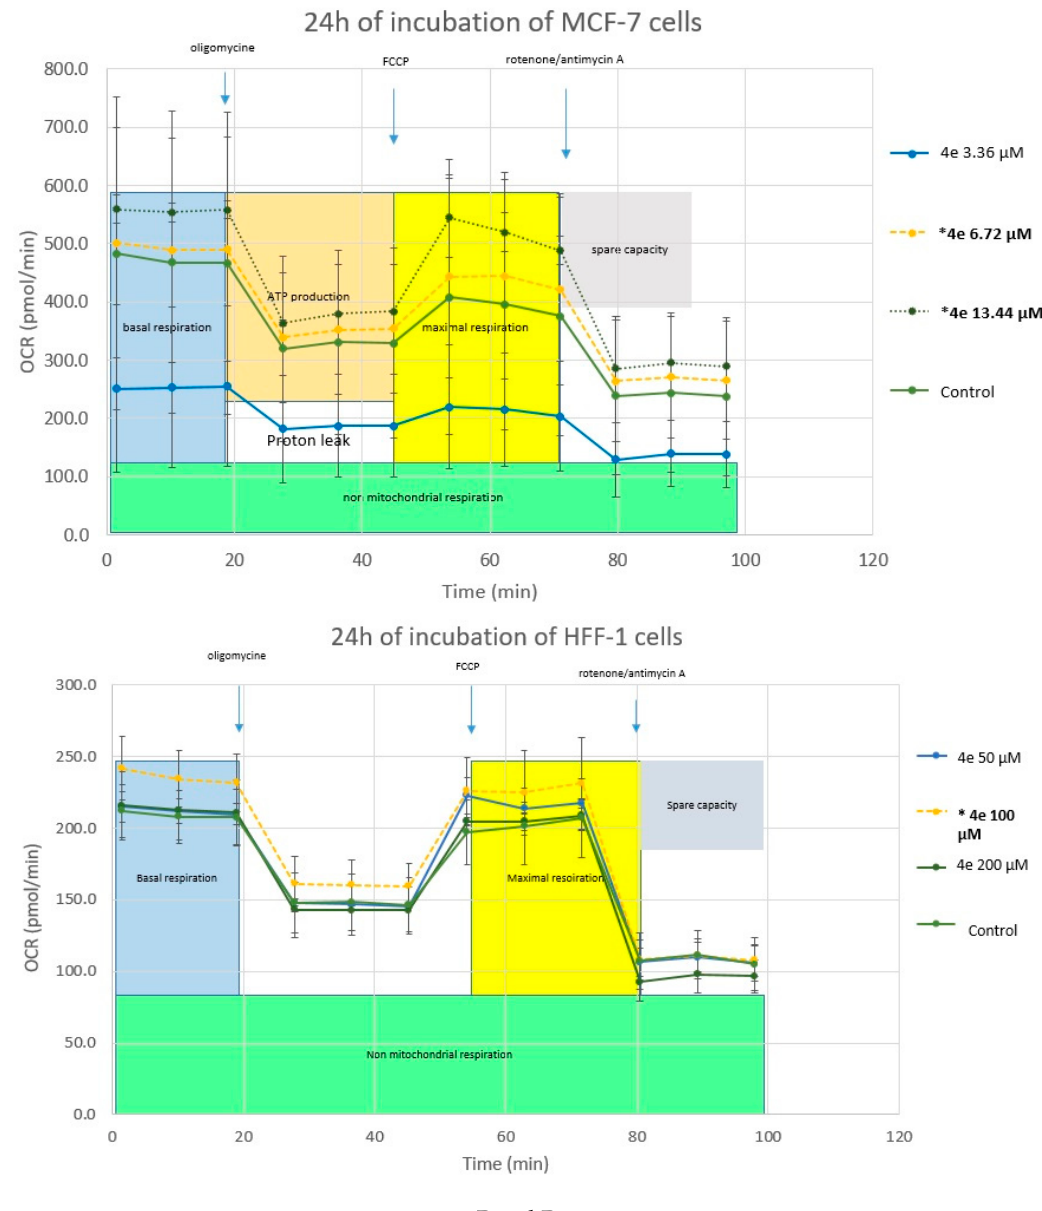
Figure 5. Results of the cell metabolism analysis for cells MCF-7 and HFF1 treated for 6 and 24 h with compound 4e having a p -bromophenyl substituent at C-4 of triazole. *The zero (0) on the X axis denotes the starting point of measurment upon addition of oligomycine, mitochondrial oxidative phosphorylation uncoupler carbonyl cyanide-4-(trifluoromethoxy)phenylhydrazone (FCCP), and rotenone/antimycin A, respectively (marked with arrows), on cells incubated with L- ASA or 4e for 24 h. Panel A —cells treated with L -ASA; Panel B —cells treated with compound 4e.